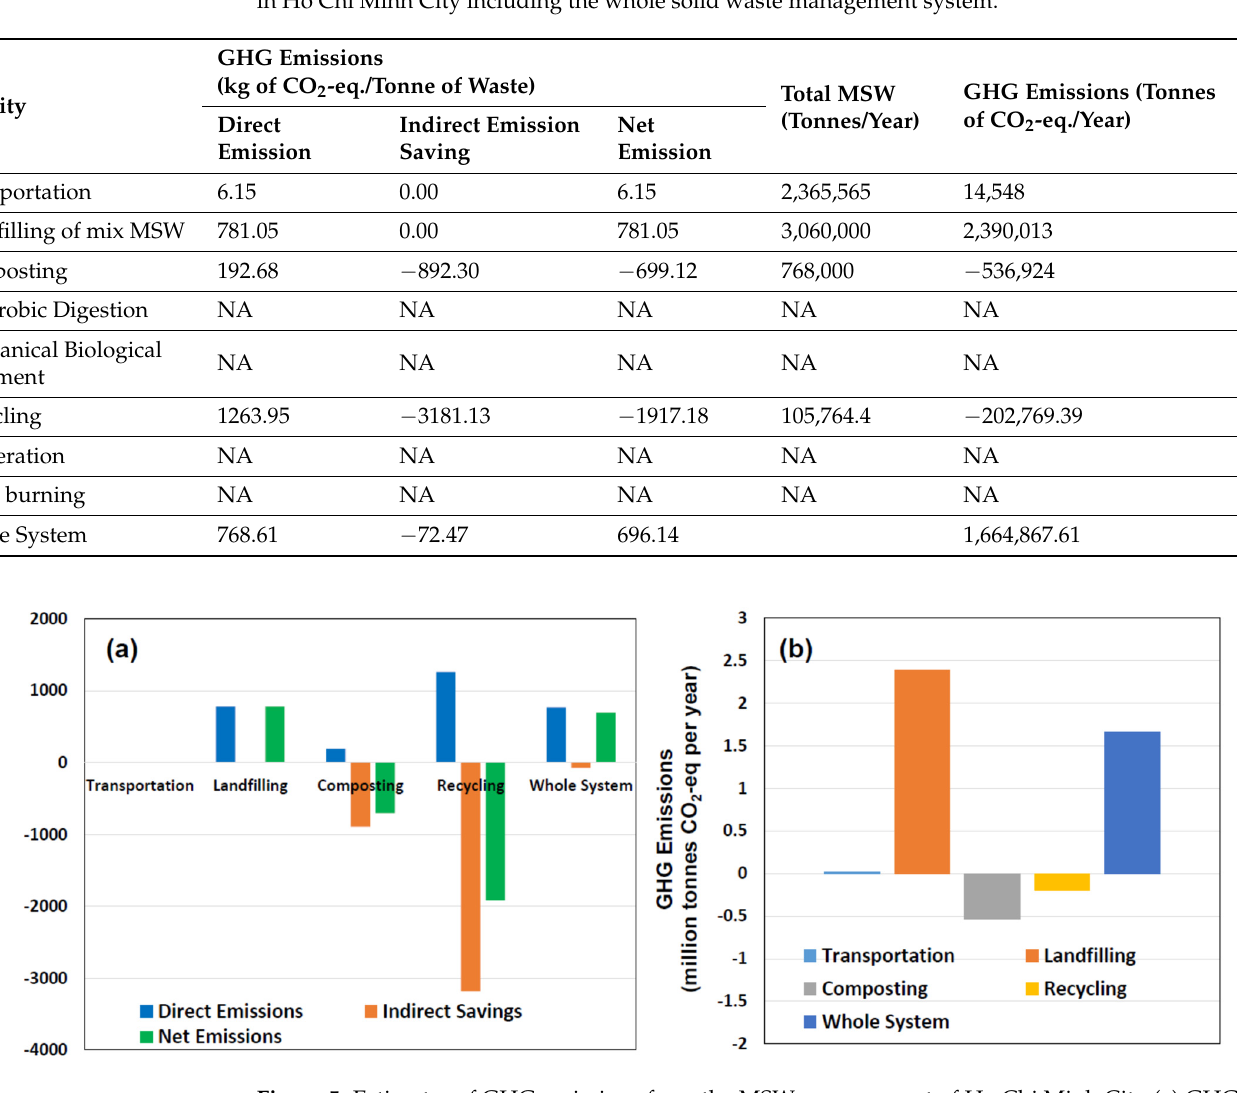
Table 6. Summary of estimates of GHG emissions from various solid waste mismanagement activities in Ho Chi Minh City including the whole solid waste management system.